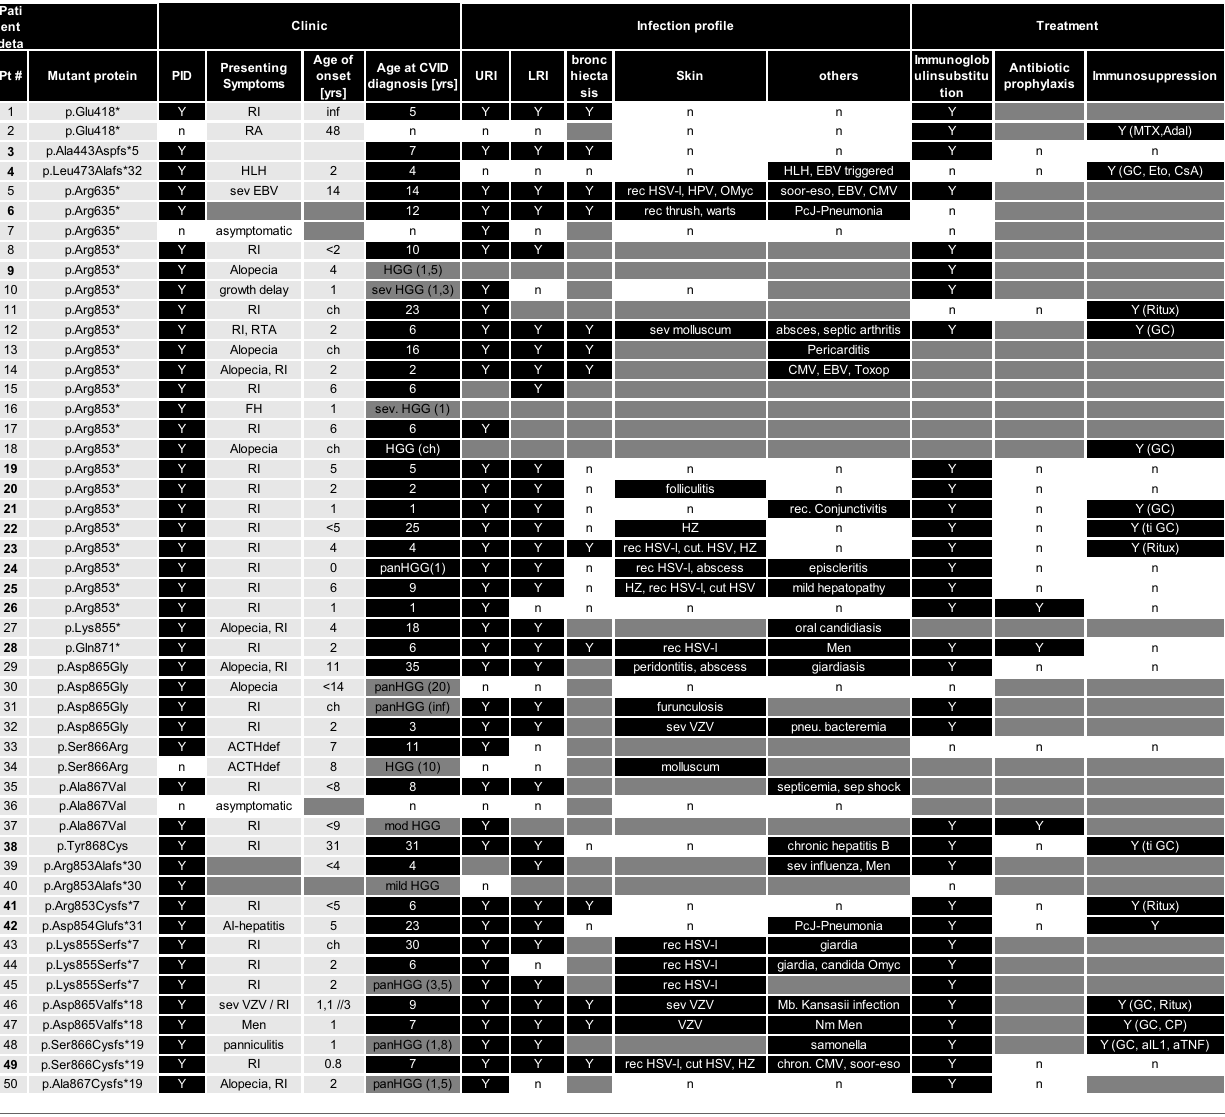
TABLE 2 | Clinical features, infection profile, and treatment of patients with NFKB2 mutations. Pati ent deta Pt # Mutant